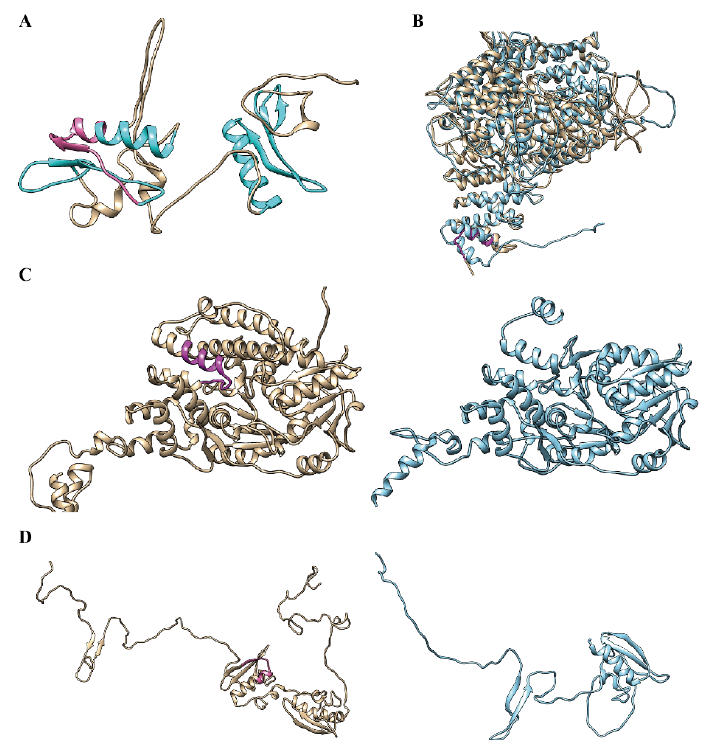
Figure 5. Structure comparison of proteins harboring micro-exons. ( A ) Structure of MH05t0027800-01 ( RSR1 ). Two AP2 domains are presented in cyan and micro-exon is in pink. ( B – D ) Structural comparison of the proteins containing micro-exon (tan) or excluding micro-exon (cyan). ( B ) is MH01t0092800-26 ( OsGI ) with a 42-nt micro-exon, ( C ) is MH03t0653800-01 ( OsSUV3 ) with a 46-nt micro-exon, and ( D ) is MH07t0148200-01 ( SNB ) with a 31-nt micro-exon. Micro-exons are highlighted in